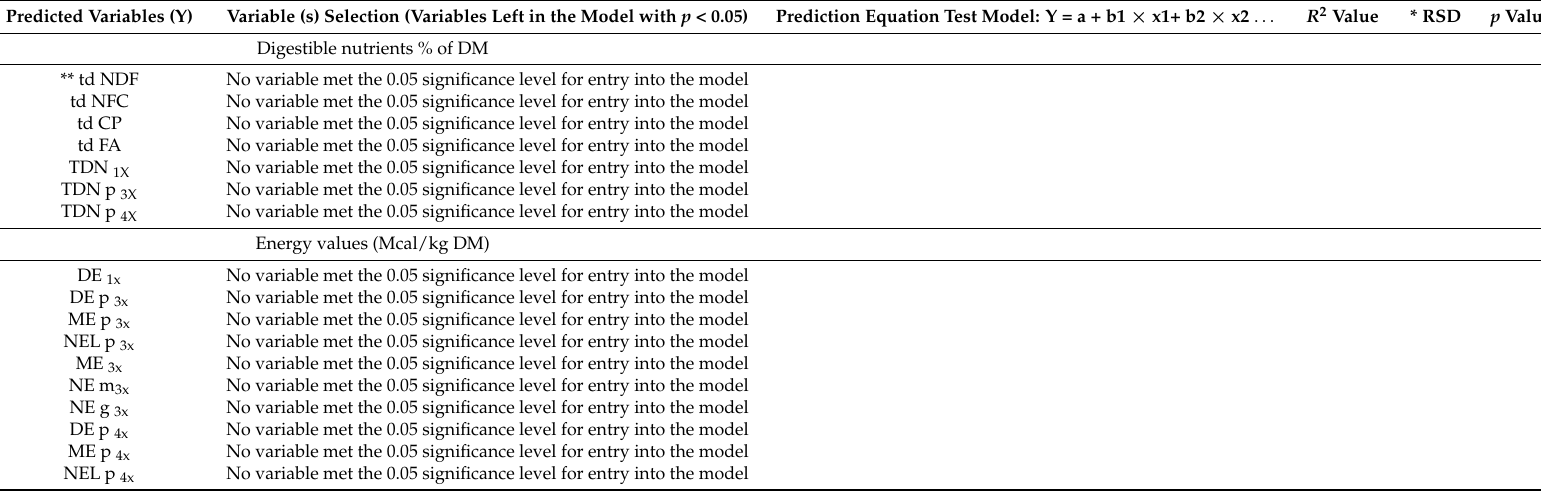
Table 13. Multiple regression analyses to find the important protein structural variables for predicting energy values of canola seeds. Predicted Variables